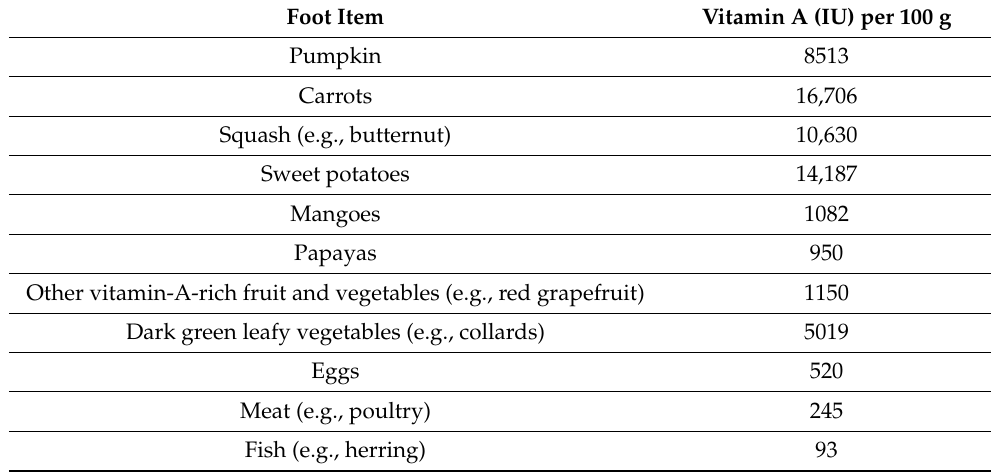
Table 1. Examples of vitamin-A-rich